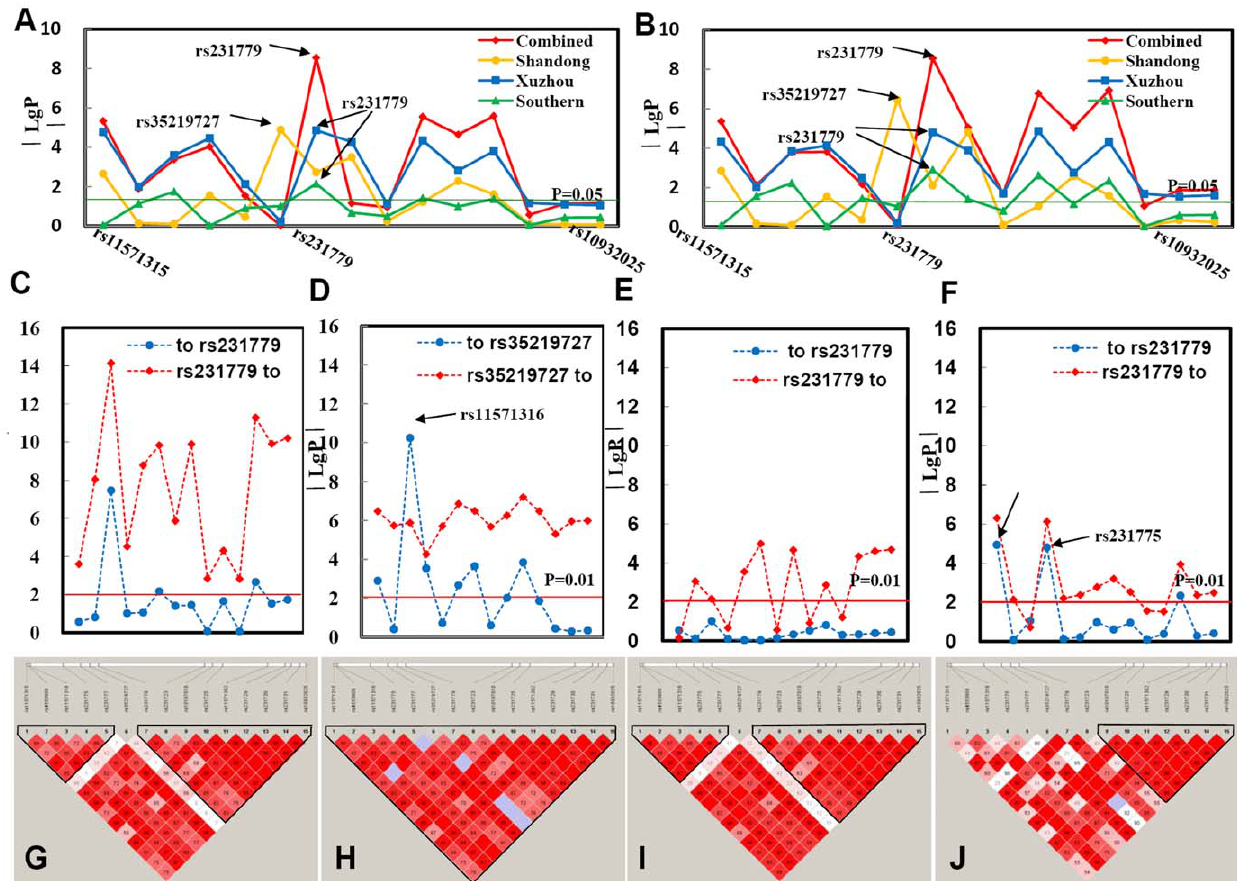
Figure 1. The results of association analysis of SNPs in the CTLA4 gene region from different populations. A total of 47 SNPs located in the CTLA4 gene region were genotyped in all subjects from different geographic regions of China. After removal of the SNPs with minor allele frequencies (MAF) , 1%, missing data above 20% or HWE p # 1 6 10 2 6 in the controls, the allele frequencies ( A ) and genotype distributions ( B ) in GD and control subjects from different populations were plotted [ 2 log10( p value) against location]. The most significantly associated SNPs in the combined Chinese Han, Xuzhou, and southern populations were all located at rs231779, with the smallest p values of 2.81 6 10 2 9 , 1.37 6 10 2 5 , 0.0071 in allele frequency difference ( A ) and 2.75 6 10 2 9 , 1.55 6 10 2 5 , 0.0013 in genotype distributions ( B ), respectively. In the Shandong population the most significantly locus was located at rs35219727, with the smallest p values of 1.30 6 10 2 5 in allele frequencies ( A ) and 3.57 6 10 2 7 in genotype distributions ( B ) (see Tables 1 and 2 for detailed information). C – F : Two-locus logistic regression analyses of rs231779 in the combined Chinese Han population ( C ), rs35219727 in the Shandong population ( D ), rs2321779 in the Xuzhou population ( E ) and rs231779 in the Southern China population ( F ). SNPs rs231779 and rs35219727were put individually into the regression models as the best makers, and all other markers were sequentially added to see if a second locus could improve the model. In the combined Chinese Han population, three of the 14 SNPs suitable for logistic regression analysis hurt the model with rs231779 ( C ), at the p value , 0.01. In contrast, we tested a regression model by taking each of 14 loci in turn and adding the test locus to it. All the markers could be improved by adding rs231779 ( C ). At the same time, in the Shandong population, rs35219727 improved the model with each of the other 14 SNPs; however, seven SNPs hurt the model with rs35219727, except SNP rs11571316 ( D ) (see Table 3 for